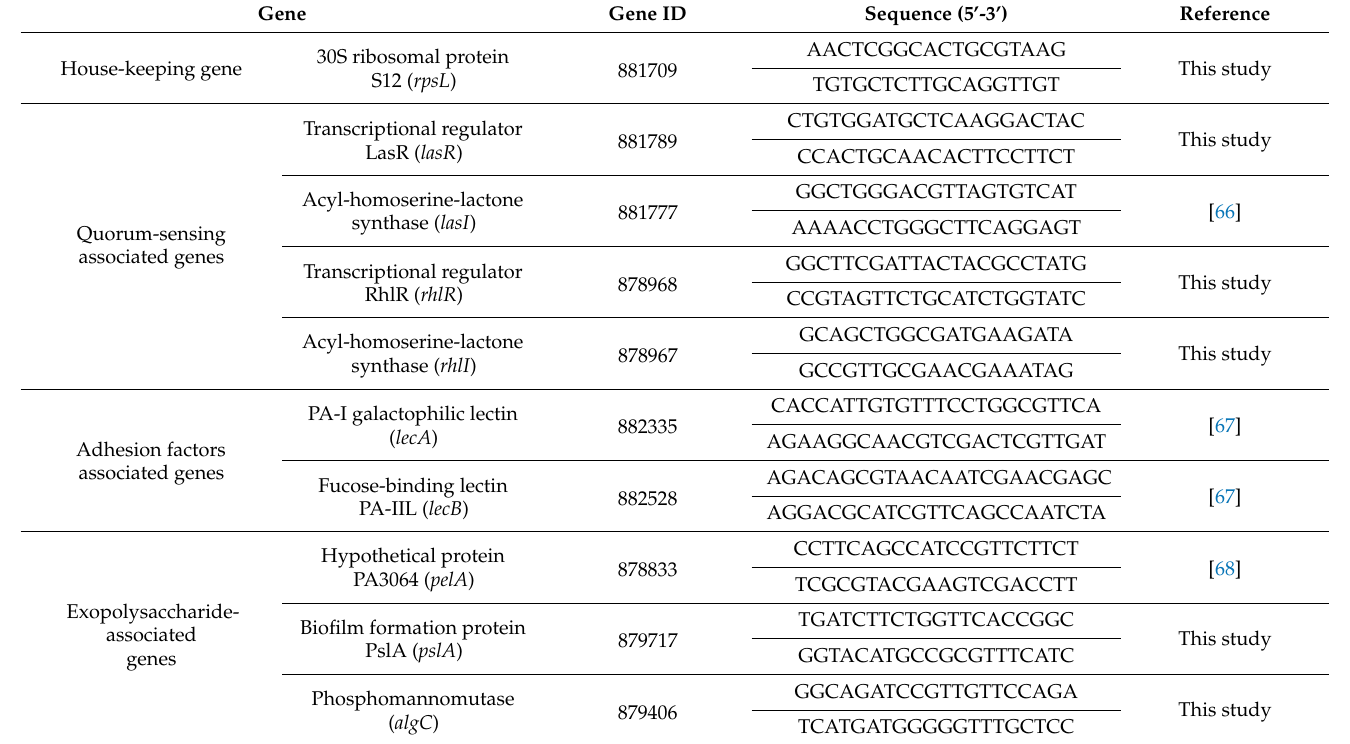
Table 1. List of primers used in the real-time PCR of selected biofilm-associated genes. Gene Gene